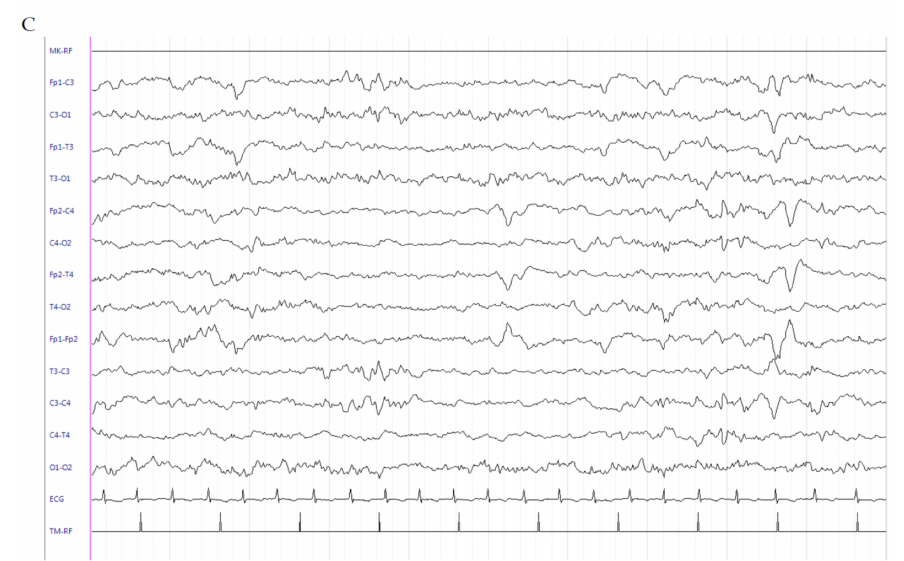
Figure 3. Electroencephalogram (EEG) of patient 3. ( A ) Multifocal medium–high-voltage generalized polyspike discharges. ( B ). Ictal EEG characterized by onset of medium-voltage, rapid, spiky activity in bilateral central regions followed by medium–high-voltage generalized polyspike discharges ( C ). Interictal EEG during quiet sleep recorded at 38 W CA, showing periodic brief sequences of variable activity; low-voltage, alpha-like activity in the central regions; tracts of di ff use background attenuation; and high-voltage sharp waves in the central regions. No epileptiform discharges were